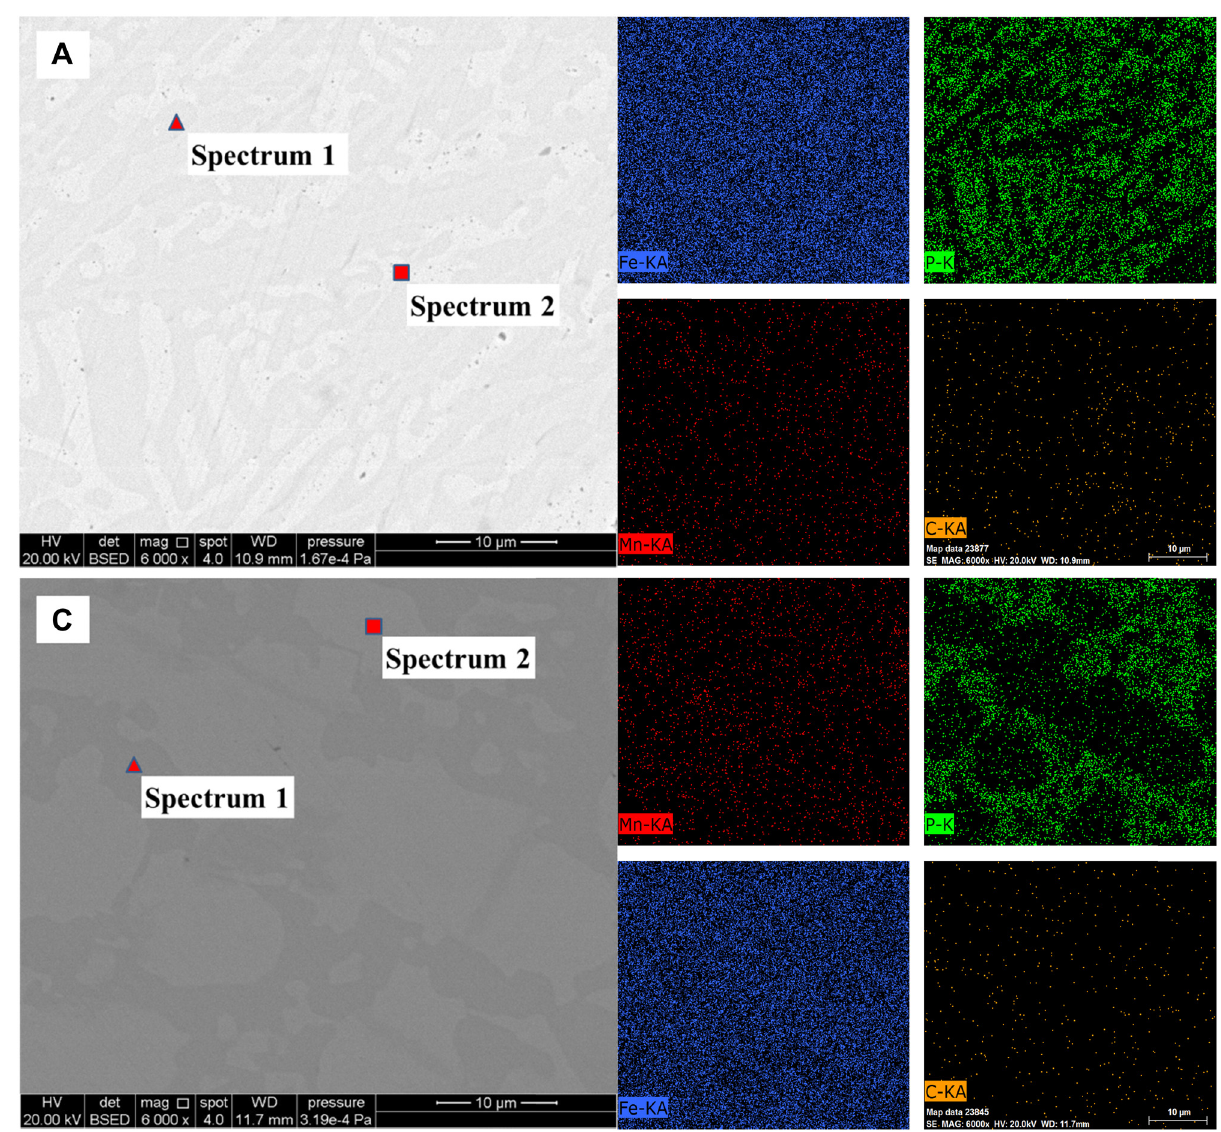
Figure 12: Backscattered electron images of metal droplets from Experiments A and C.